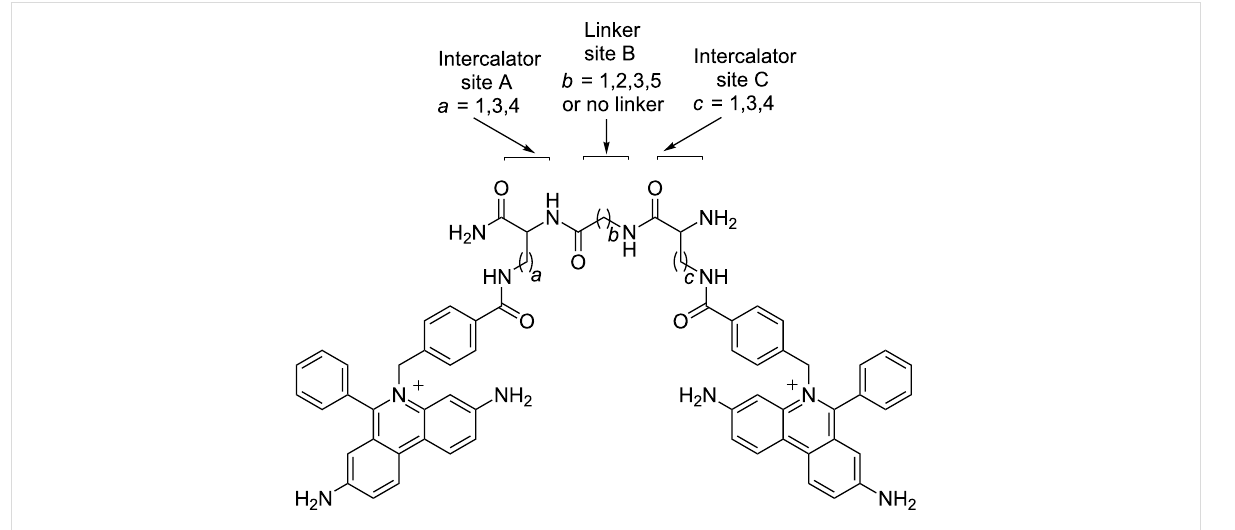
Another large series of phenanthridinium-homodimers was constructed by linking two ethidium bromide subunits by peptide-like linkers of variable flexibility and rich in hydrogen- bonding possibilities within the DNA grooves (Figure 5). The resulting bis-intercalators (in comparison to the monomeric analogues) revealed significantly increased